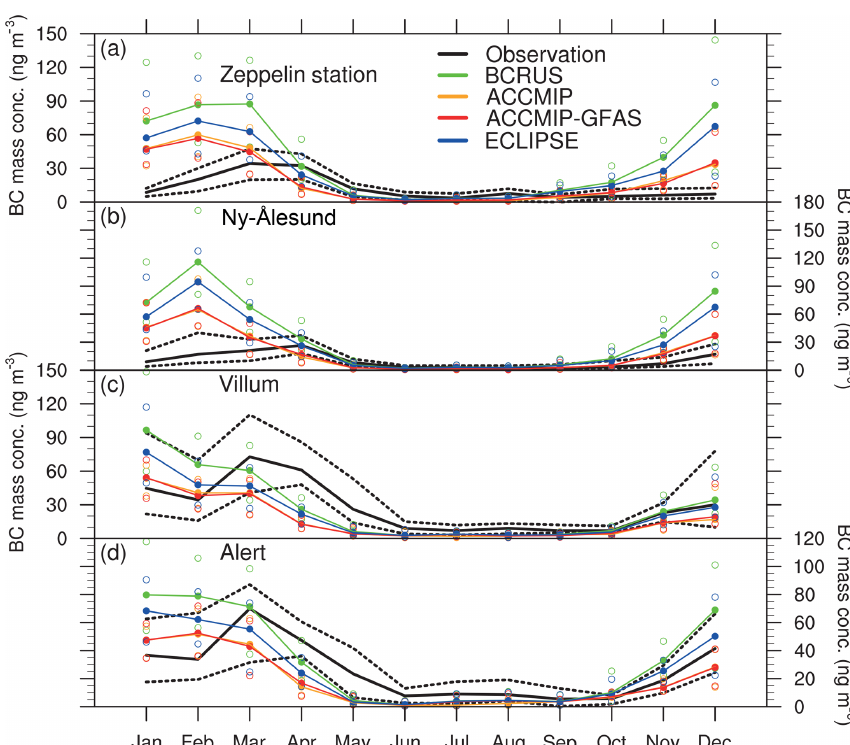
Figure 6. Near-surface BC mass concentrations for Atlantic Arctic stations. Solid black line shows the multi-year monthly median BC mass concentration observed in (a) Zeppelin Station, (b) Ny-Ålesund, (c) Villum and (d) Alert. See Fig. 9 for the geographical locations. Dashed black line indicates the observed upper and lower quartiles. In color are the median different model runs with solid lines and filled circles, and the upper and lower quartiles run with empty